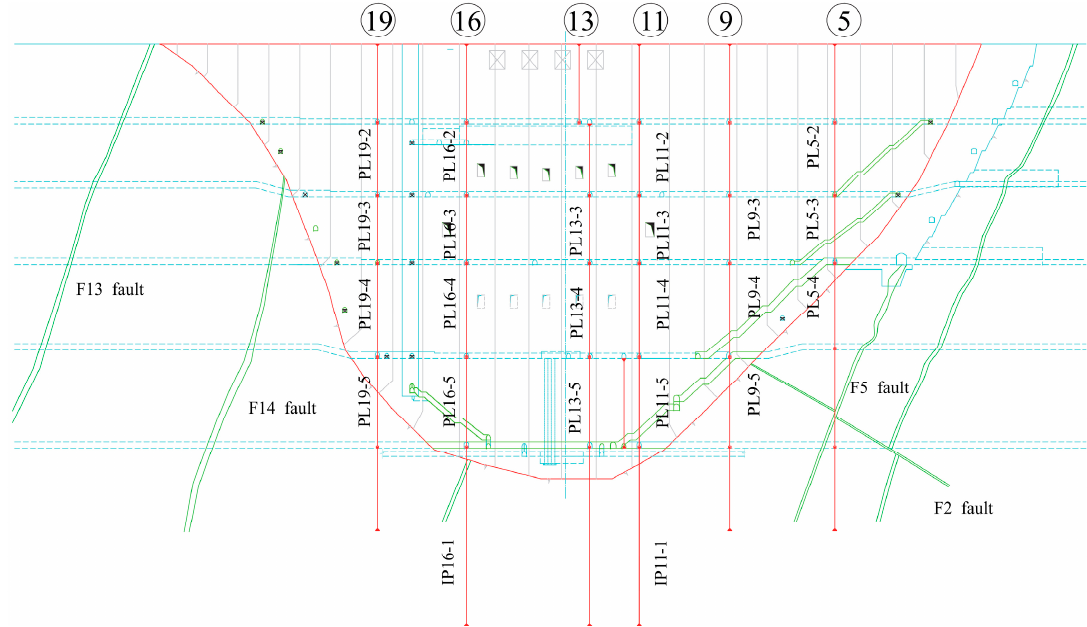
Figure 5. Layout diagram of dam deformation monitoring.